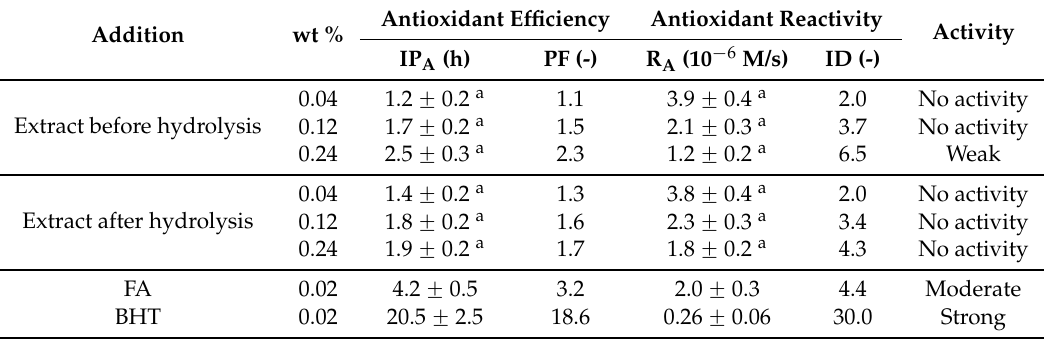
Table 2. Main kinetic parameters characterizing the triacylglycerols of sunflower oil (TSG) autoxidation at 80 °C in presence of following extracts from flaxseed.